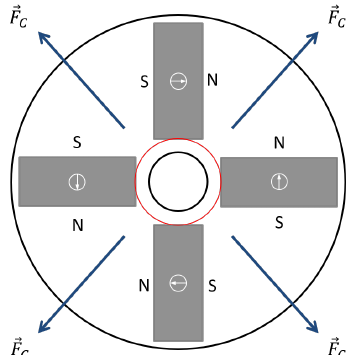
Figure 6. centrifugal force (cid:126) A C acting on spoke rotor.